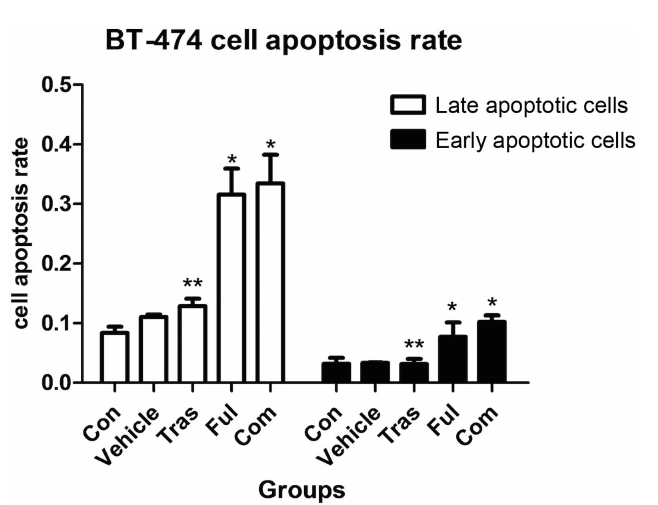
It was clear that fulvestrant as a single agent or combined with trastuzumab induced both, early stage apoptosis ( P < 0.001 for both) and late stage apoptosis ( P = 0.013 for the fulvestrant- treated group and P = 0.002 for combination group) in BT-474 cells. However, no statistical differences in the rates of cell apoptosis were observed between the two groups receiving ful- vestrant as a single agent or in combination with trastuzumab (Fig 2 and Table 2). Besides, no increase in the rate of cellular apoptosis was observed in the trastuzumab-treated group for the BT-474 cell line (Fig 2 and Table 2) and in all the treatment groups for ZR-75-1 cell line (Fig 3 and Table 3).